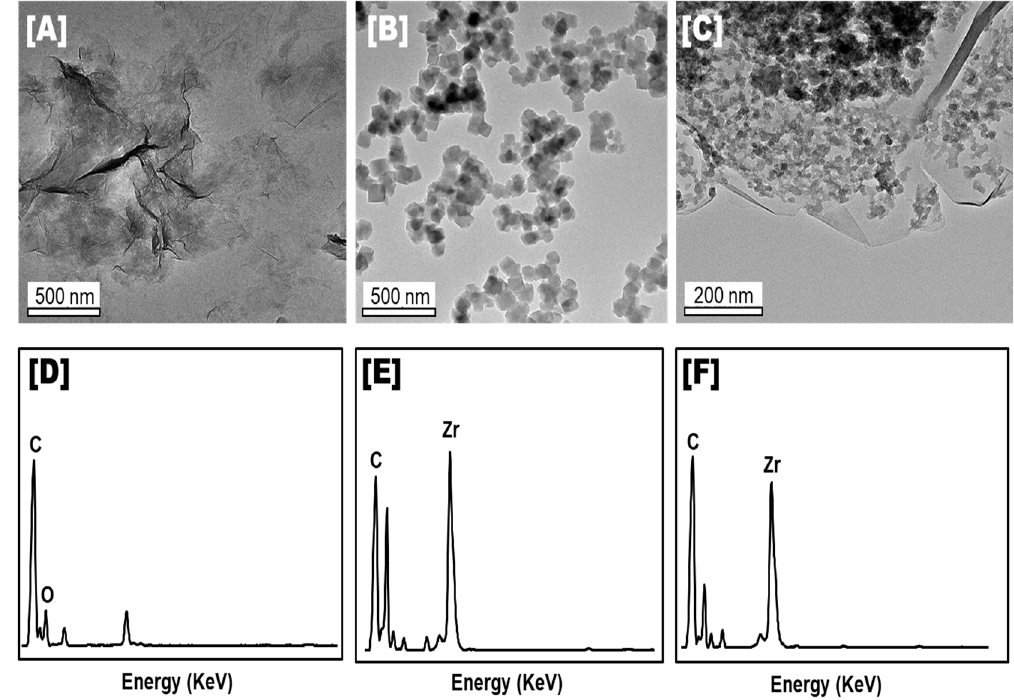
Figure 2. TEM images of ( A ) GO, ( B ) UiO-66, and ( C ) composite (UiO-66_GO-5) and EDS spectra of ( D ) GO, ( E ) UiO-66, and ( F ) composite (UiO-66_GO-5).